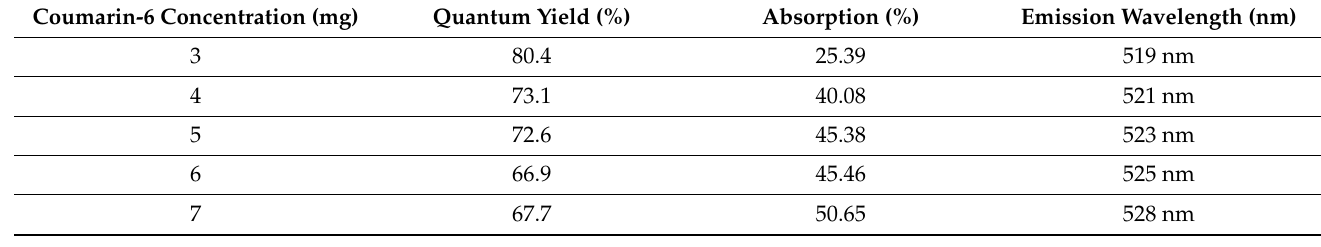
Table 2. Quantum yield and absorption of the different concentrations of coumarin-6.